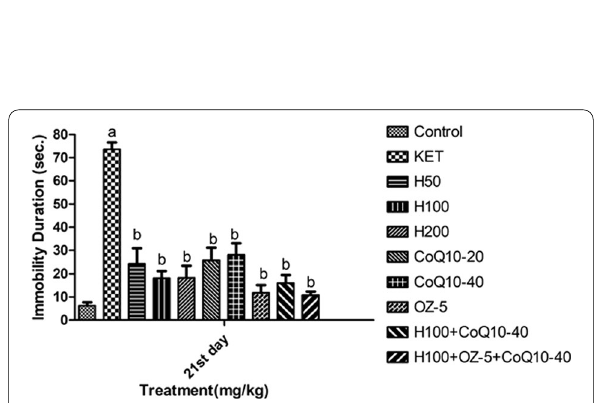
Fig. 3 Effect of hesperidin, coenzyme Q 10 and their combinations elevated performance task. IAL Retention transfer latency, 2nd RTL Second Retention transfer latency. Data were analyzed by two-way ANOVA followed by the Bonferroni test. = All values were expressed as Mean SEM. a p < 0.05 as compared to naive, b p < 0.05 as compared to ketamine. KET, Ketamine; H, Hesperidin; CoQ10, ± Coenzyme Q10; OZ, Olanzapine